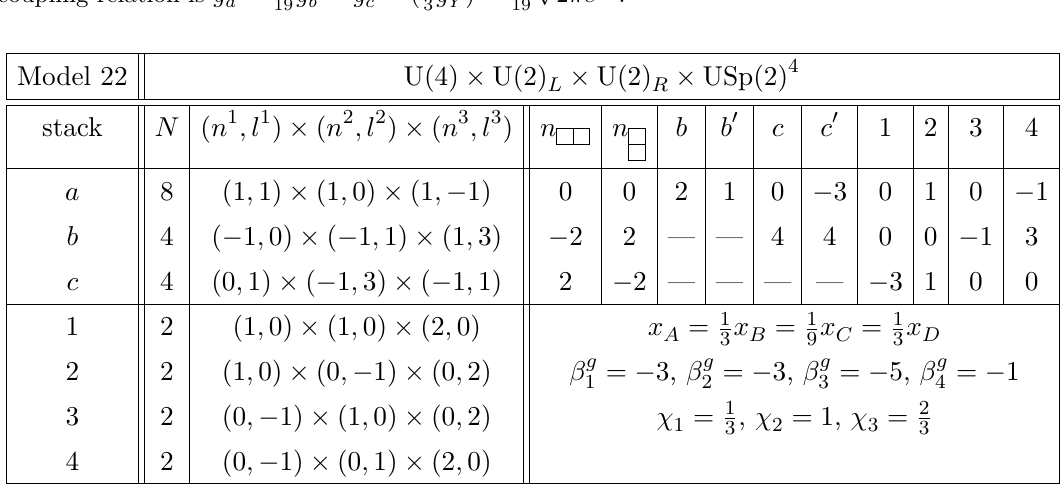
Table 29 . D6-brane configurations and intersection numbers of Model 22, and its MSSM gauge